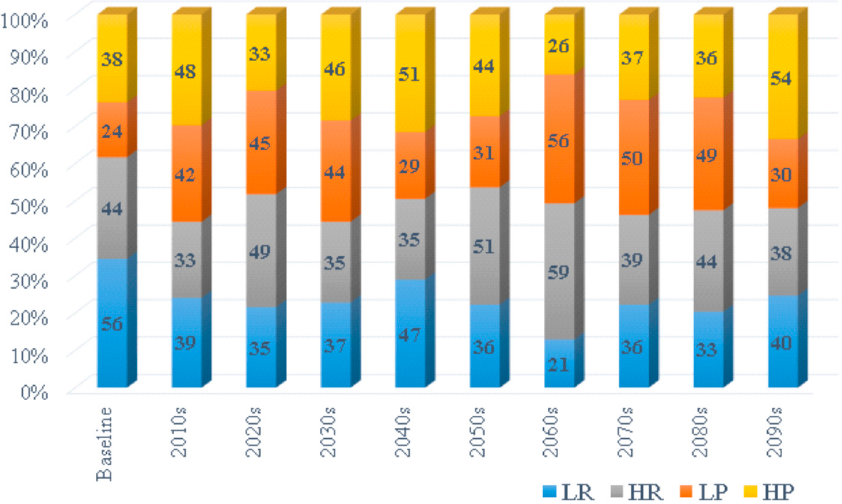
Figure 8. Regional distribution of sensitivity types for scenario RCP 8.5. The 2030s had the highest number of water ‐ poor regions and the 2010s and 2030s had the highest number of LR regions.